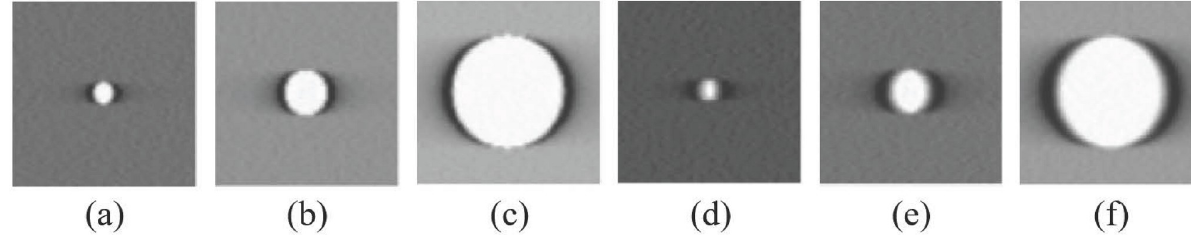
Fig 4. Reconstructed images of spherical signals in (a—c) step-and-shoot mode, and (d—f) continuous mode. Signal diameters are (a, d) 1 mm, (b, e) 2 mm, and (c, f) 5 mm. The display window is set by [min. max.] mm − 1 .